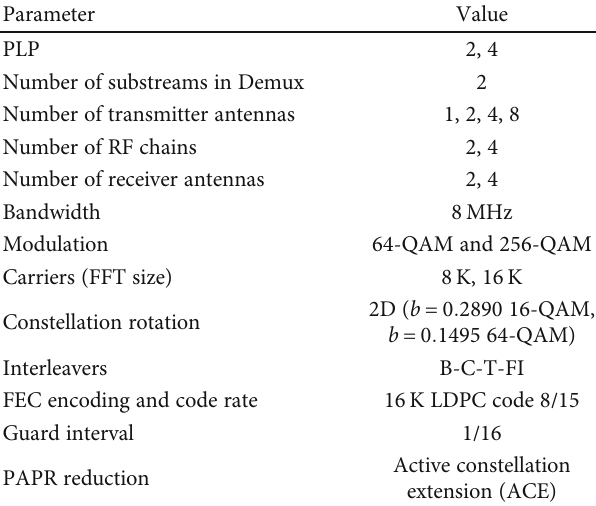
Table 3: Simulation